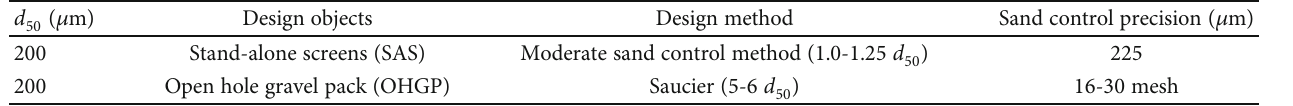
Figure 6: Metal mesh premium screen. Table 1: Two methods for determining the sand control parameter